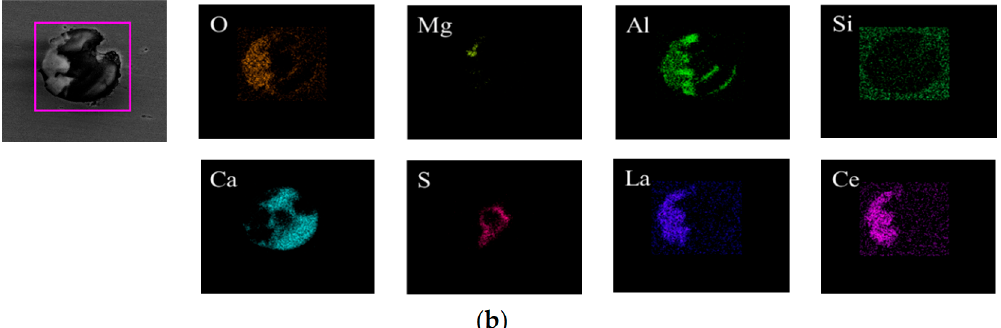
Figure 5. Surface scanning results for inclusions in the steel at the end of the RH refining process. ( a ) (La, Ce)Al 2 O 3 +CaS-MgO-Al 2 O 3 , ( b ) (La, Ce)Al 2 O 3 +CaS-MgO-Al 2 O 3 -CaO.